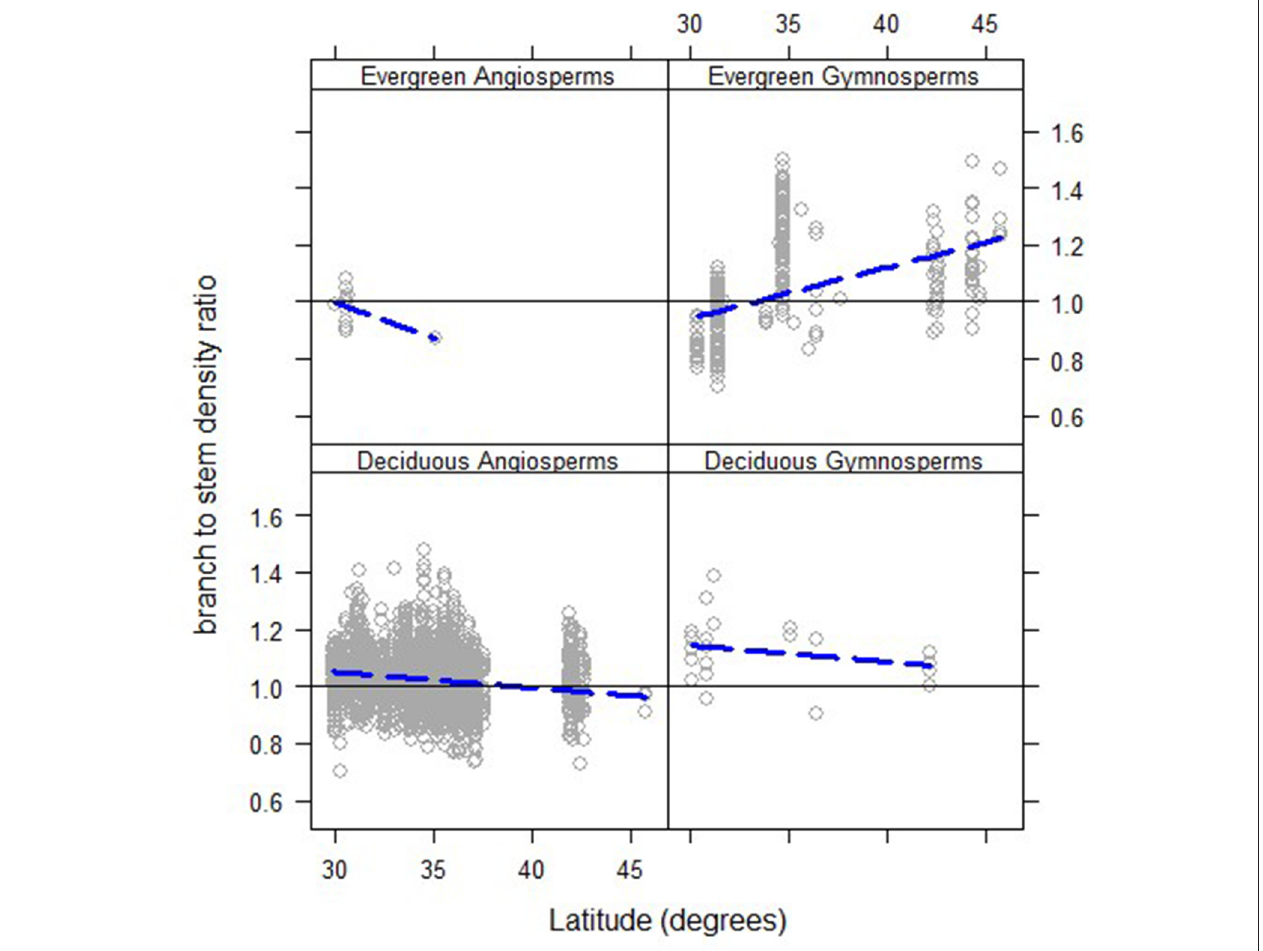
FIGURE 7 | Branch wood: stem wood basic density ratios as a function of the latitude of the tree’s growing location (long-dashed lines) for North American trees (gray circles) for trees of different functional types. Only the relationship for evergreen gymnosperms has a slope that is statistically different from 0 ( α =